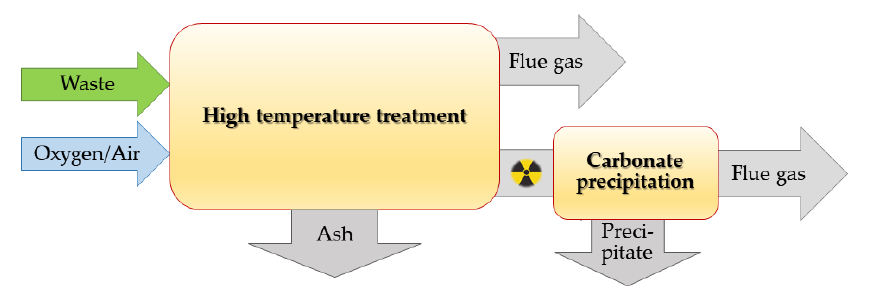
Figure 7. High temperature treatment of graphite and carbonaceous